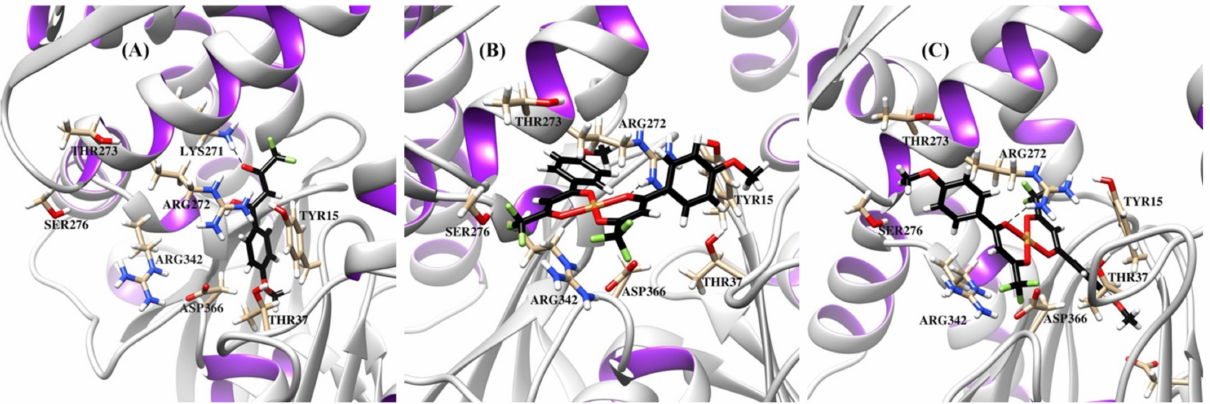
Figure 9. Ribbon representation of the Hsp70 protein with bound compounds H L1 ( A ), cis -[Cu( L1 ) 2 ] ( B ), and trans - [Cu( L1 ) 2 ] ( C ). Binding site showing selected amino acids and hydrogen bonding (dashed lines) between the compounds and Lys271,